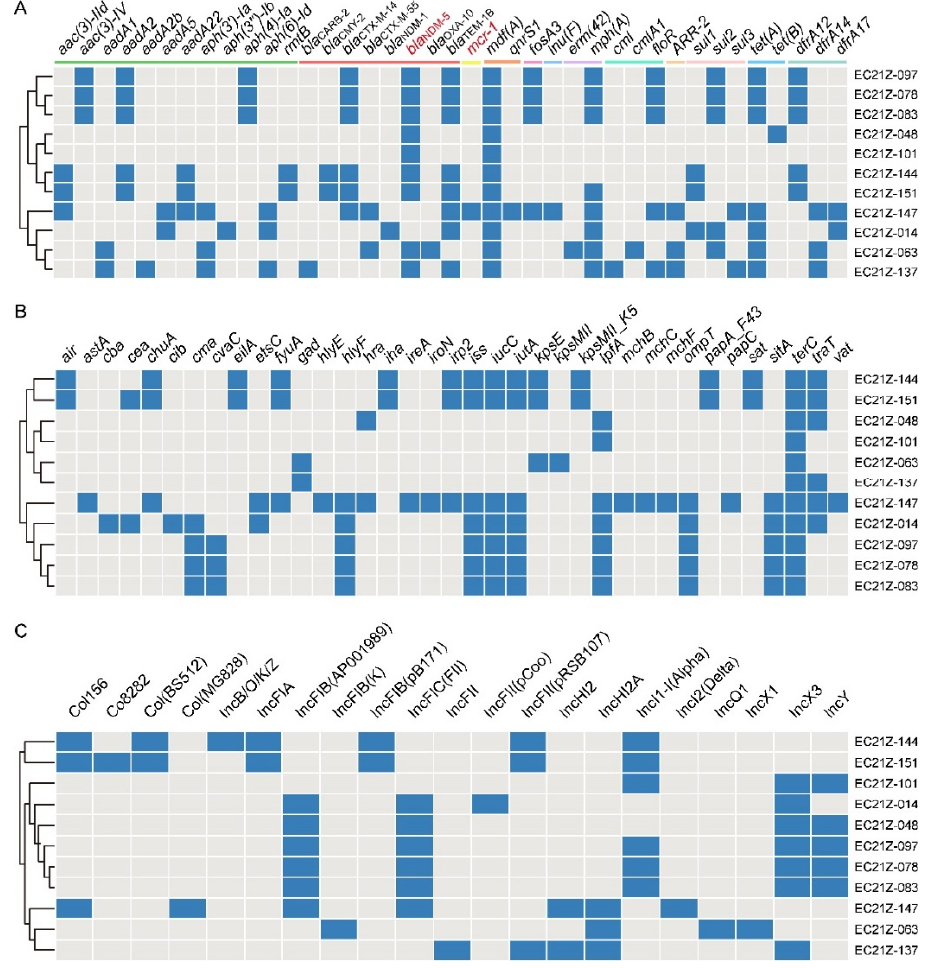
Figure 4. The diagram of ARGs, virulence genes, and replicon types of the 11 strains. ( A ) The blue boxes indicate the positive ARGs. ( B ) The virulence genes in E. coli strains. ( C ) The various plasmid replicons in E. coli strains.